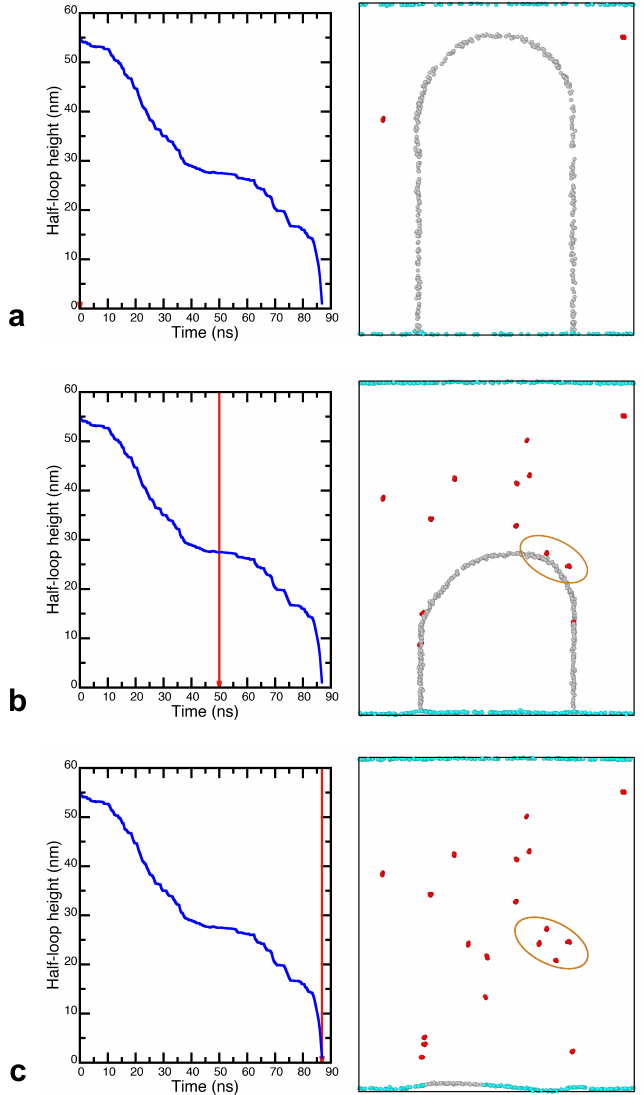
Figure 5. Displacement–time curve for a GB moving in the 1.25 at.%Ag alloy at the temperature of 1000 K (left column) in comparison with GB images at the moments of time indicated by the vertical red line. ( a ) Initial GB. ( b ) GB after 50 ns of simulation. ( c ) GB at the end of the simulation. Atoms with FCC environment are invisible. The GB atoms are shown in gray and the Ag clusters containing five or more atoms are shown in red. The oval indicates the group of clusters responsible for the plateau in the displacement curve. Note how, in ( b ), the GB bows out toward these